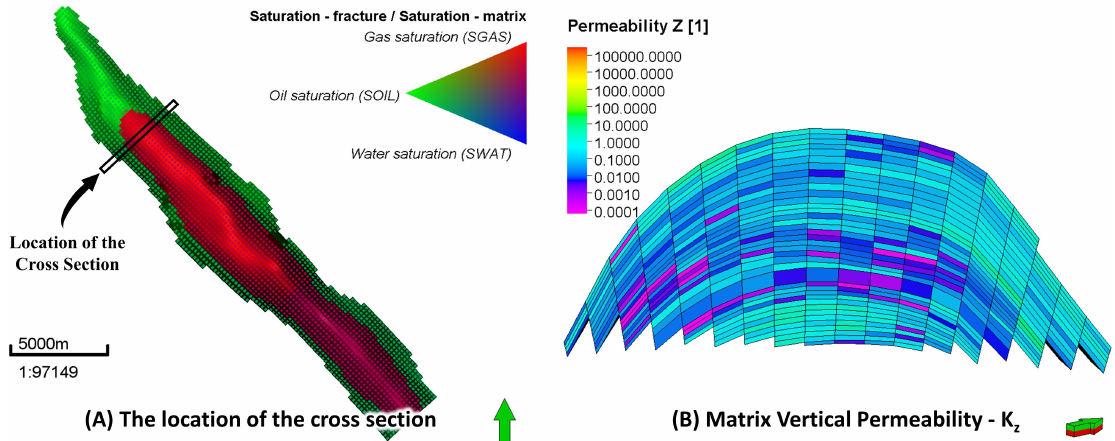
Figure 16. ( A ) The initial fluid distribution in the Qamchuqa reservoir, with the illustration of the IK cross-section location. ( B ) Vertical permeability of the matrix medium for the IK